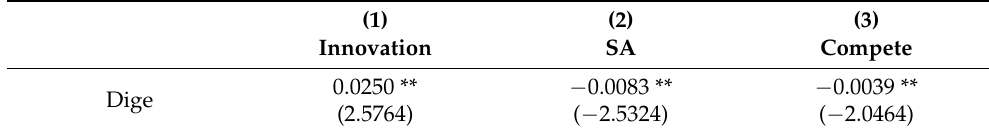
Table 9. Analysis of impact